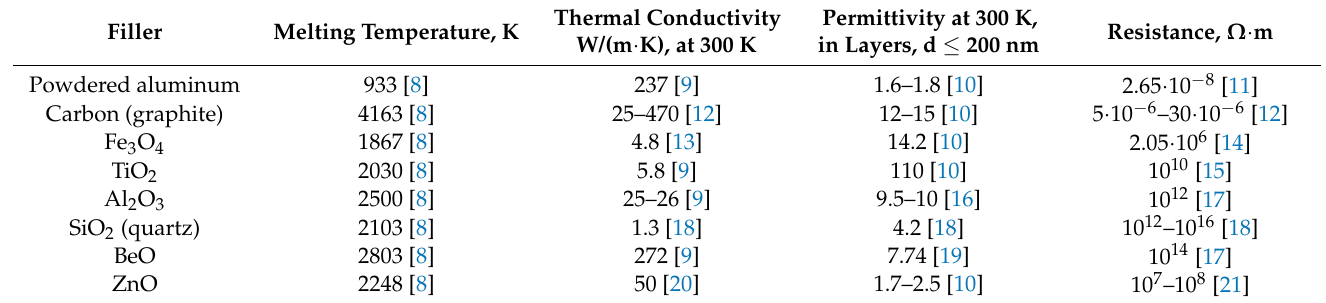
Table 1. Comparative characteristics of the